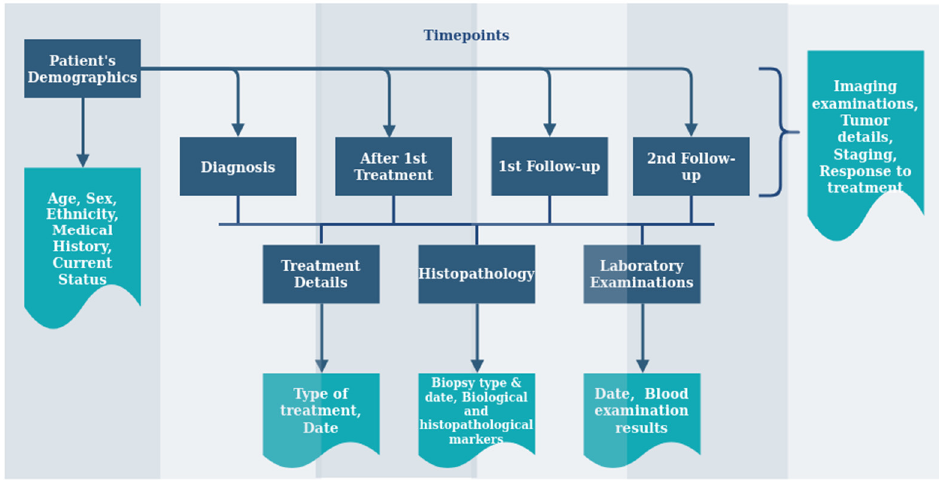
Figure 1. The data collection schema.